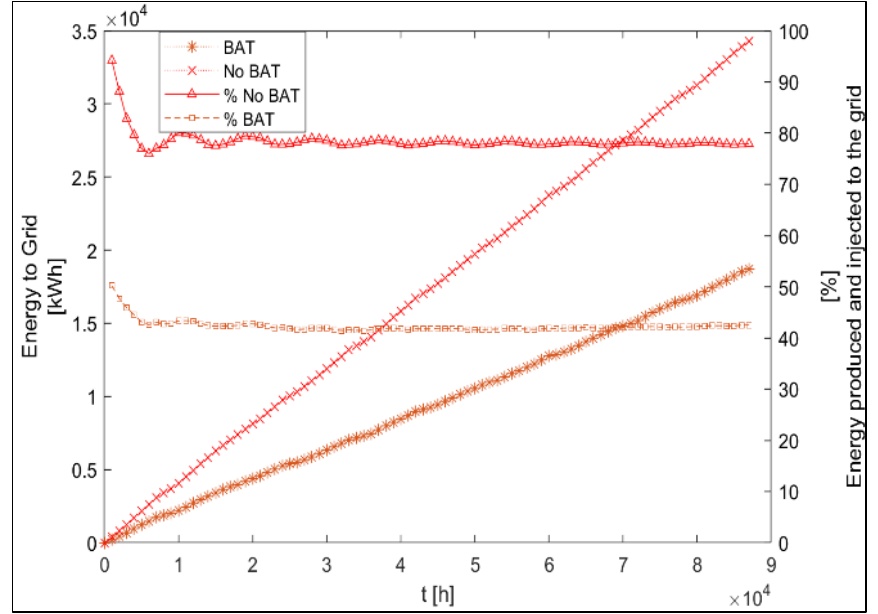
Figure 15. Expected progressive energy production injected to the grid.